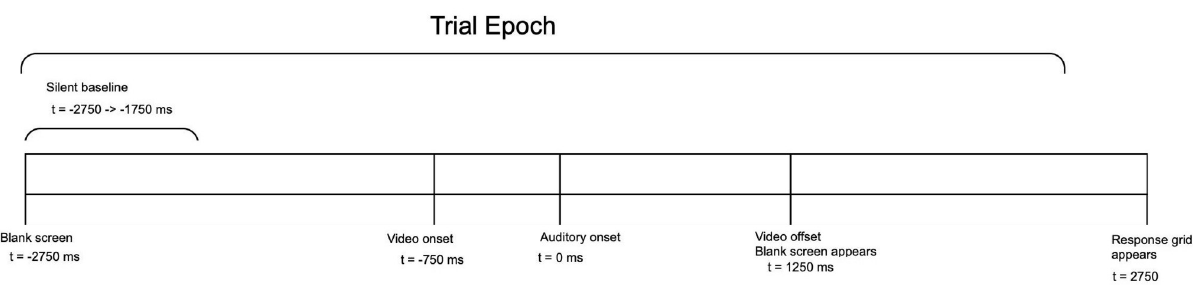
Fig 1. Epoch timeline. 4750 ms trial epoch timeline for single trials across all perceptual conditions.